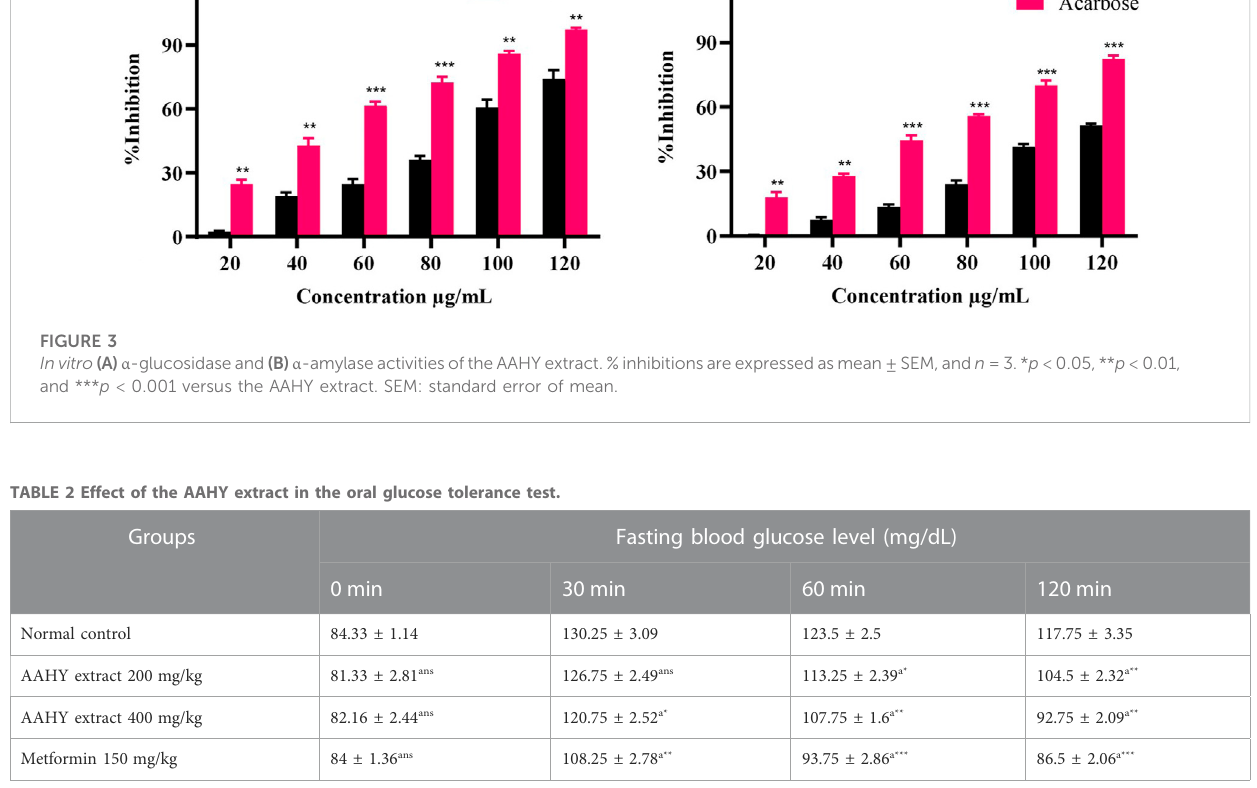
The values are represented as mean ± SEM, and n = 6 for each group. a All treated groups versus the normal control group at the corresponding time